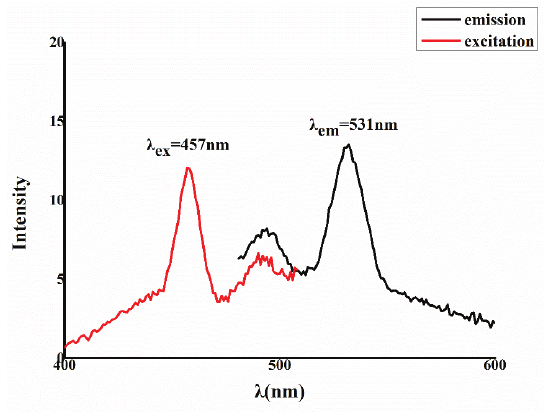
Figure 4: Emission & excitation spectra of complex 1 in acetone, at room temperature.